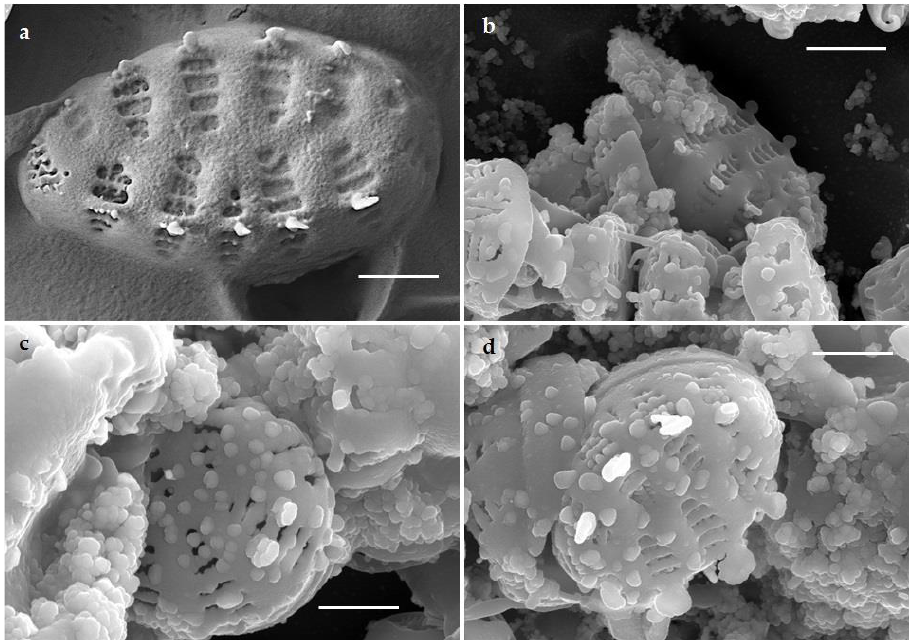
Figure 5. SEM images of control ( a ) and silver treated ( b – d ) frustules of G. mutabilis and confirmed the deposition of nanoparticles on surfaces of Ag treated cells [scale bar 1 µm].